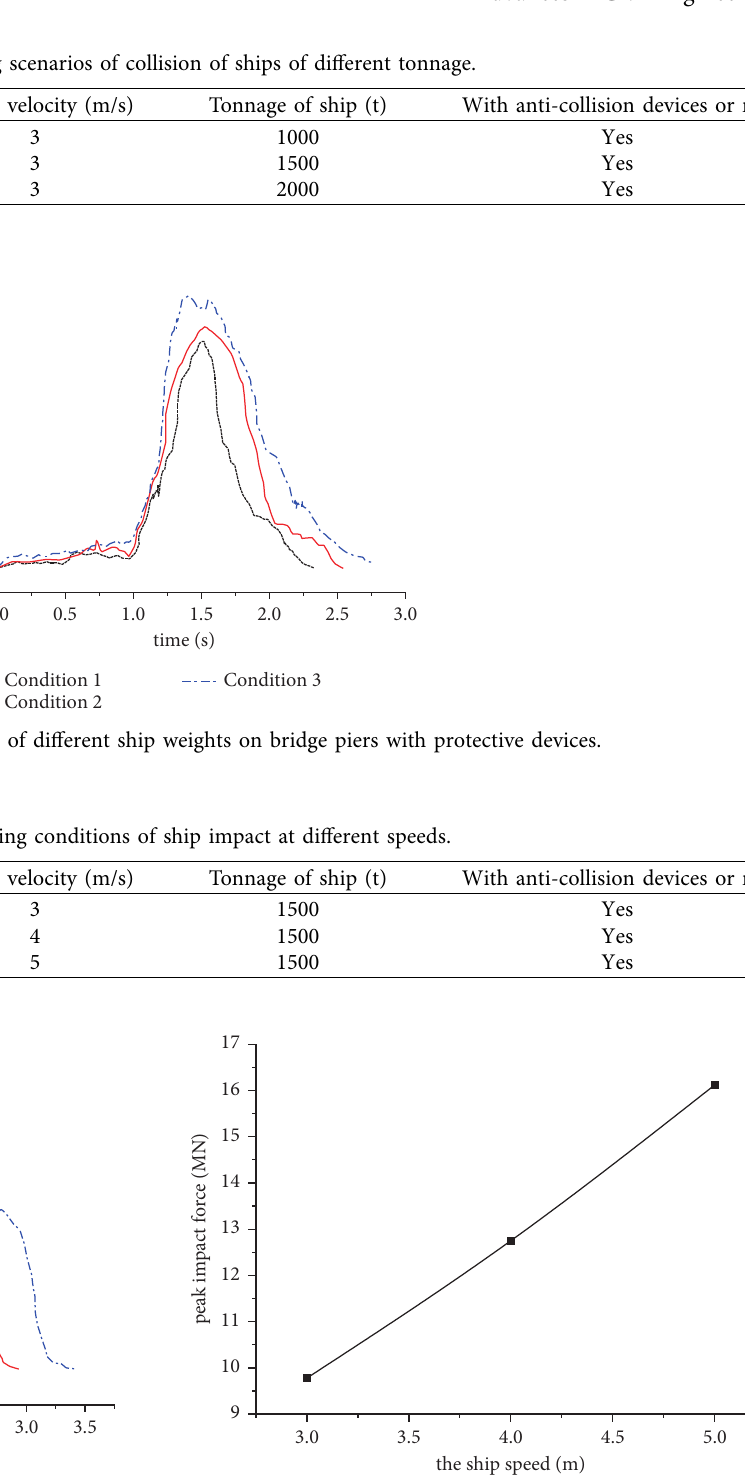
Figure 11: Relationship between peak impact force and ship speed at different impact